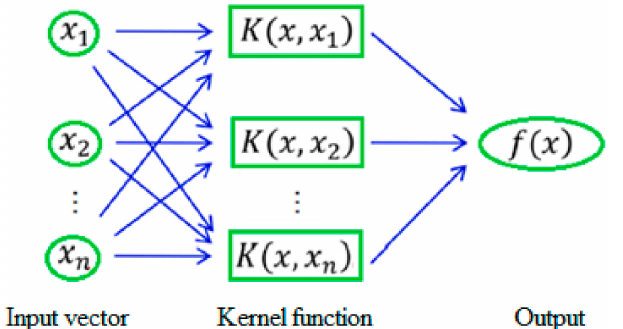
Figure 6. SVM model comprising of three-layer. Here x n represents inputs M, η , α and ϕ , K ( x , x n ) is the kernel function and f ( x ) is the predicted base pressure ( β